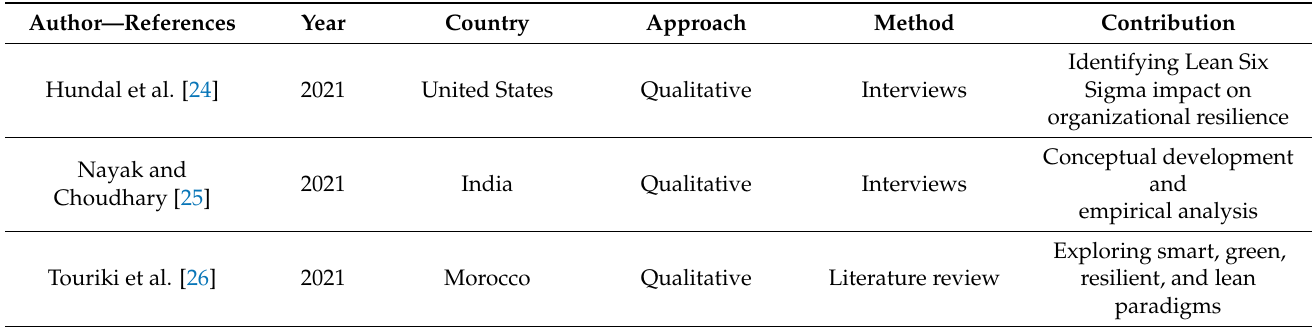
Table 1. The content analysis of the papers in the final stage of